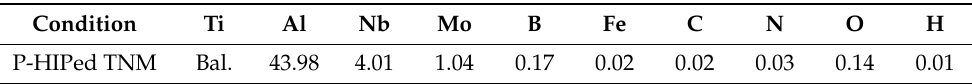
Table 1. The chemical composition of the P-HIPed TNM ingot (at. %). Condition